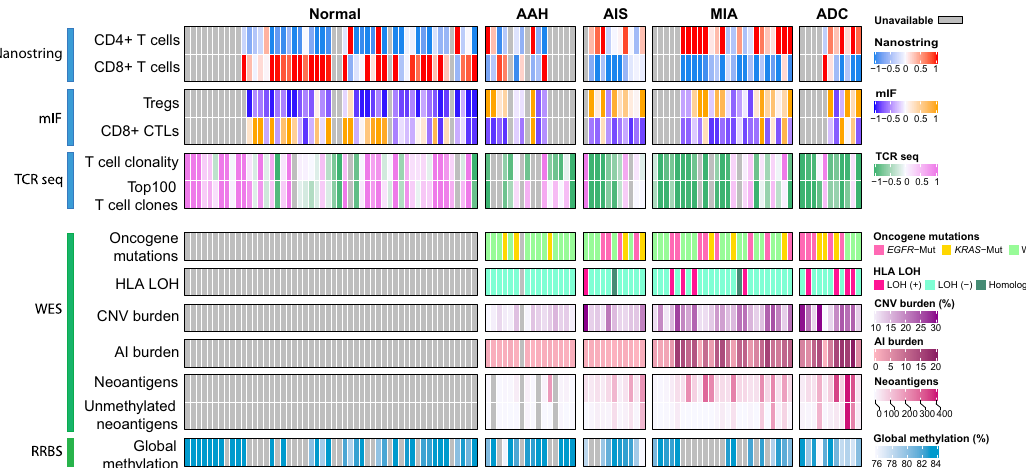
Fig. 1 The immune landscape IPNs of different stages and associated genomic and epigenomic features. In fi ltration CD4 + T cells, CD8 + T cells inferred from immune gene expression using TIMER; regulatory T cells (Tregs, CD3 + CD8 – FOXP3 + ) and CD8 + cytotoxic T lymphocytes (CTLs,CD3 + CD8 + granzyme B + ) measured by multiplex immuno fl uorescence (mIF); T cell clonality and frequency of the top 100T cell clones by TCR sequencing are shown in upper panel. Genomic alterations from whole exome sequencing (WES) including EGFR / KRAS mutations, HLA LOH, copy number variation (CNV) burden, allelic imbalance (AI) burden, total number of mutations associated with predicted neoantigens, and total number of mutations associated with predicted neoantigens without promoter methylation; global methylation status using long interspersed transposable elements-1 (LINE-1) as a surrogate marker accessed by reduced representation bisul fi te sequencing (RRBS) are shown in bottom panel. Data from 53 patients was used including AAH (typical adenomatous hyperplasia), AIS (adenocarcinoma in situ), MIA (minimally invasive adenocarcinoma), and ADC (invasive adenocarcinoma). (Source data is provided as a source data fi